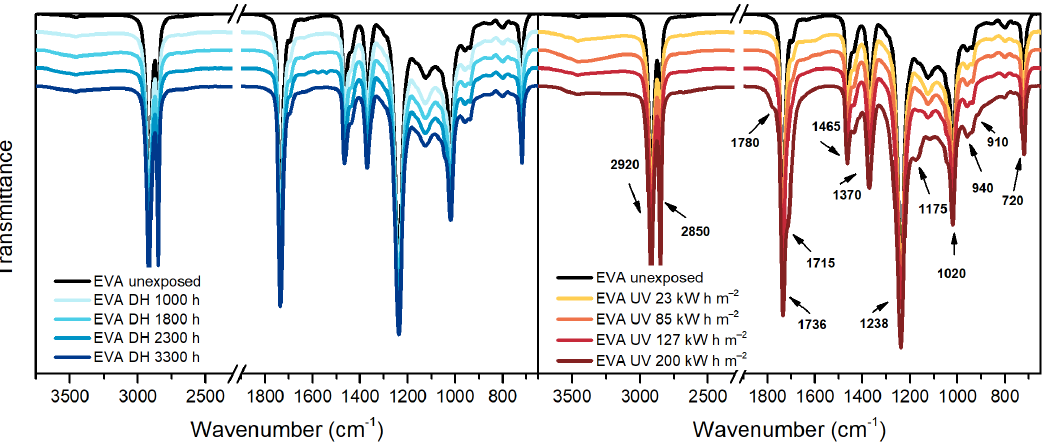
Figure 4. Fourier Transform Infrared in Attenuated total reflectance mode (FT-IR ATR) Spectroscopy measurements of EVA samples before and after exposure to DH (left) and UV test (right).